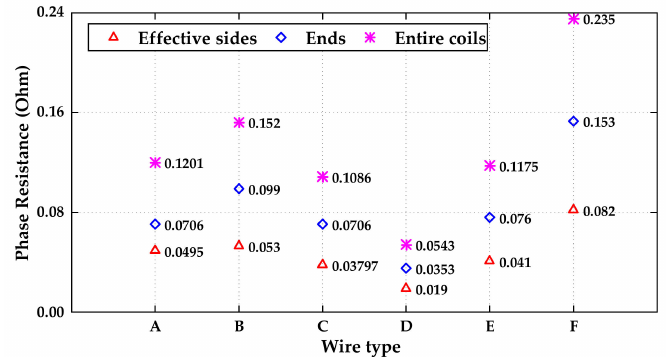
Figure 11. Resistance distribution results with different wire types.